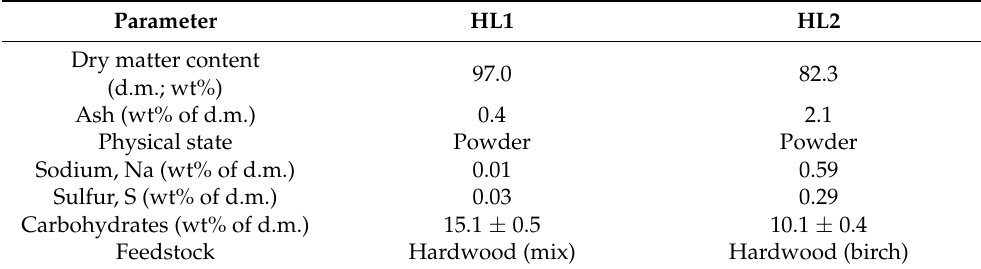
Table 4. Characteristics of hydrolysis lignins studied in this